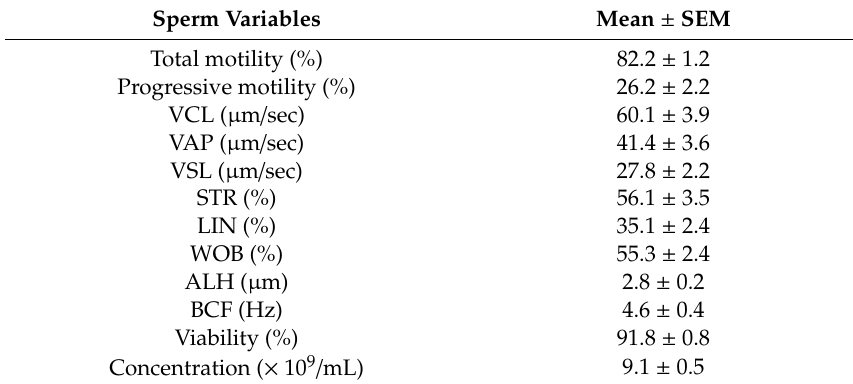
Table 3. Sperm quality variables (means ± standard error of means—SEM) recorded in freshly collected turkey semen (n =